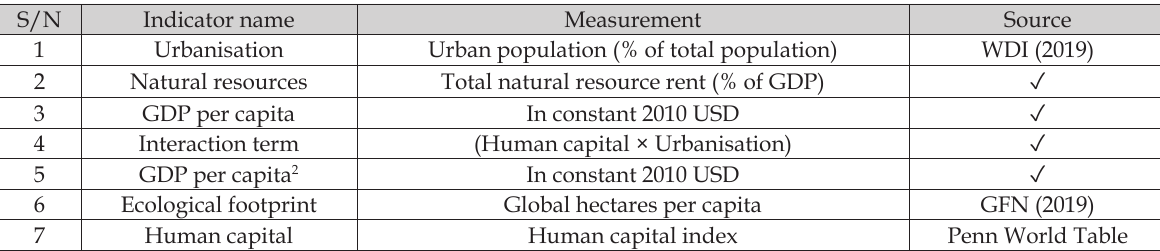
Table 2. Measurement and source of